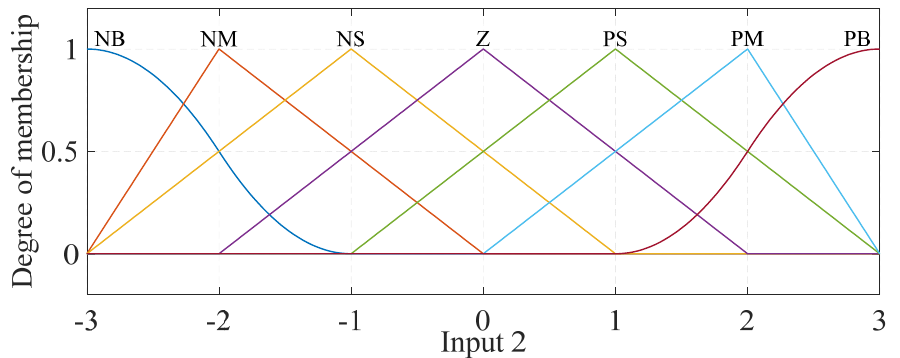
Figure 6. Membership functions for input 2 (wind turbine actuator sensor). Table 4. Membership function, fuzzy set labels, and fuzzy numbers representation for Figure 6.